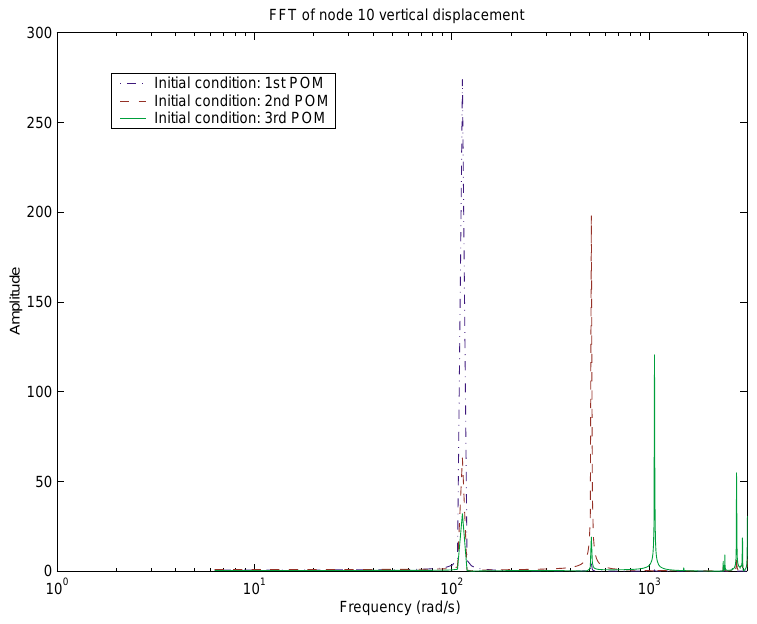
Fig. 9. FFT of node 10 vertical displacement and having as initial conditions the first three POMs presented in Fig. 4.